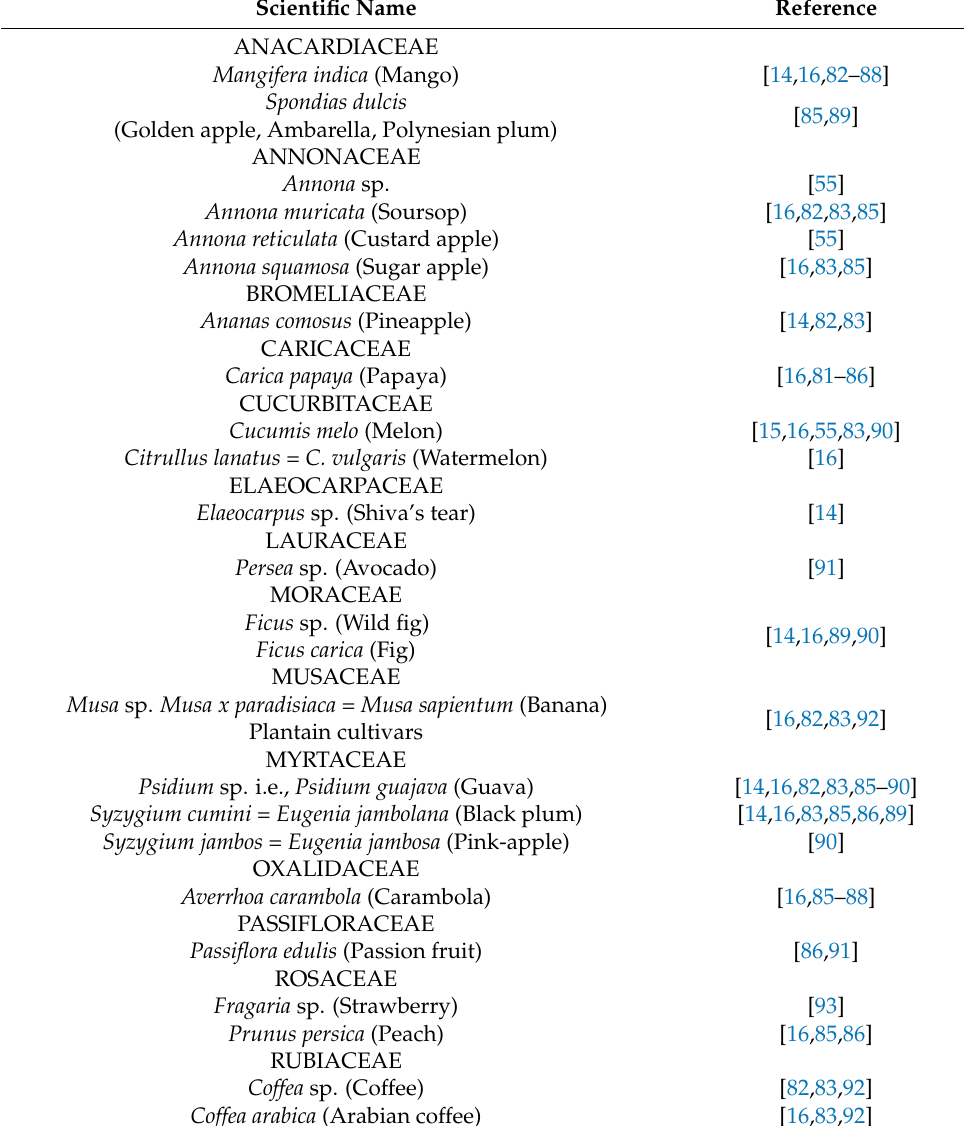
Table 2. List of fruit species and cultivars pierced by Eudocima phalonia in New Caledonia (for the botanical classification, references are found on www.catalogueoflife.org and